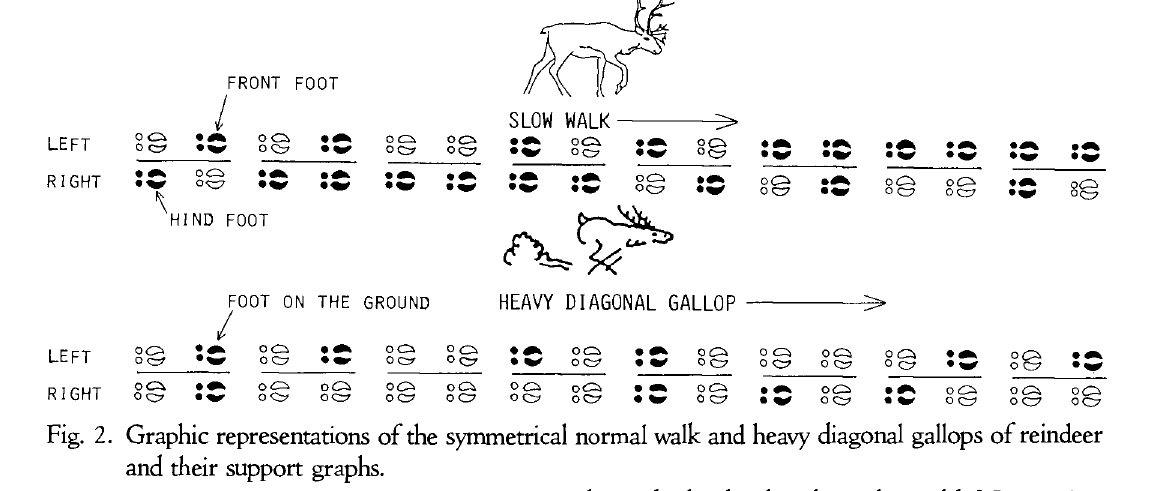
Fig. 2. Graphic representations of the symmetrical and their support